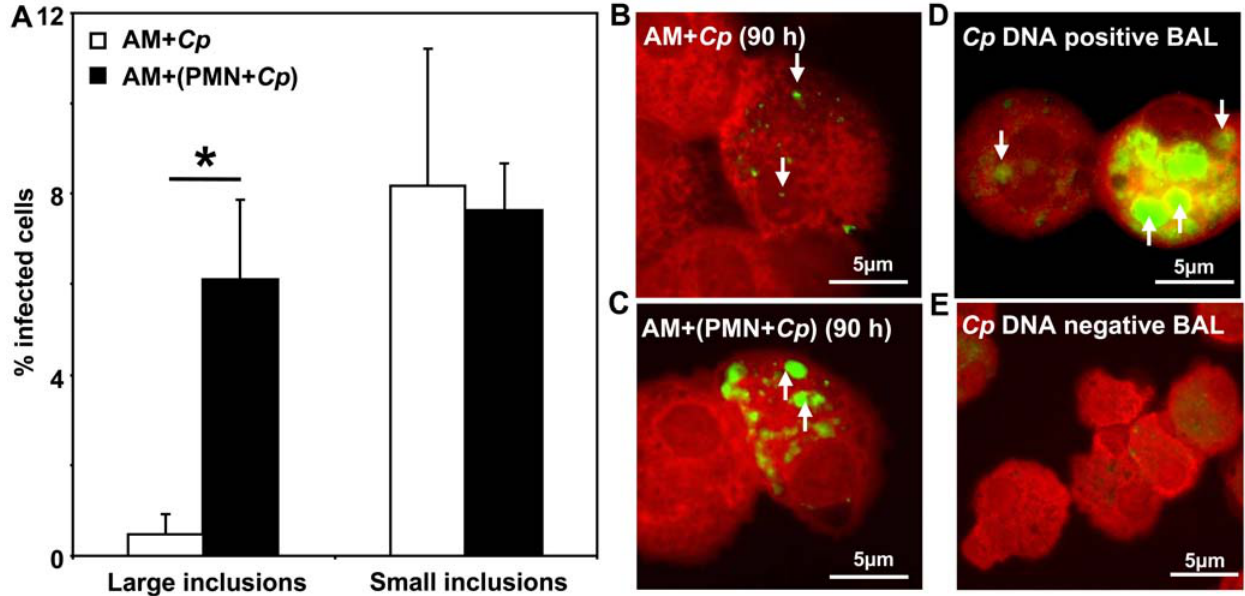
Figure 5. Alveolar macrophages harbor intracellular chlamydiae in vivo . Alveolar macrophages (AM) isolated from BAL fluids of C. pneumoniae - DNA negative patients were either directly infected with C. pneumoniae (open bars) or co incubated with C. pneumoniae infected PMN at a ratio of 1:1 (closed bars, 66 h p.i.). The percentage of AM harvesting large and small inclusions were calculated 90 h p.i. by counting a minimum of 200 cells/slide using a FITC- labeled anti- C. pneumoniae LPS- staining protocol ( A ). Significantly more large chlamydial inclusions were detected in AM co incubated with C. pneumoniae - infected apoptotic PMN than in directly infected AM ( A–C , p=0.02). In addition, we analyzed AM from BAL fluids of patients suffering from community-acquired pneumonia (CAP) by fluorescence microscopy ( D, E ; representative experiment out of 4), showing both small, persistent-like inclusions (downward arrows) and large inclusions (upward arrows) in C. pneumoniae - DNA positive BAL ( D ) but not in C. pneumoniae - DNA negative BAL ( E ).